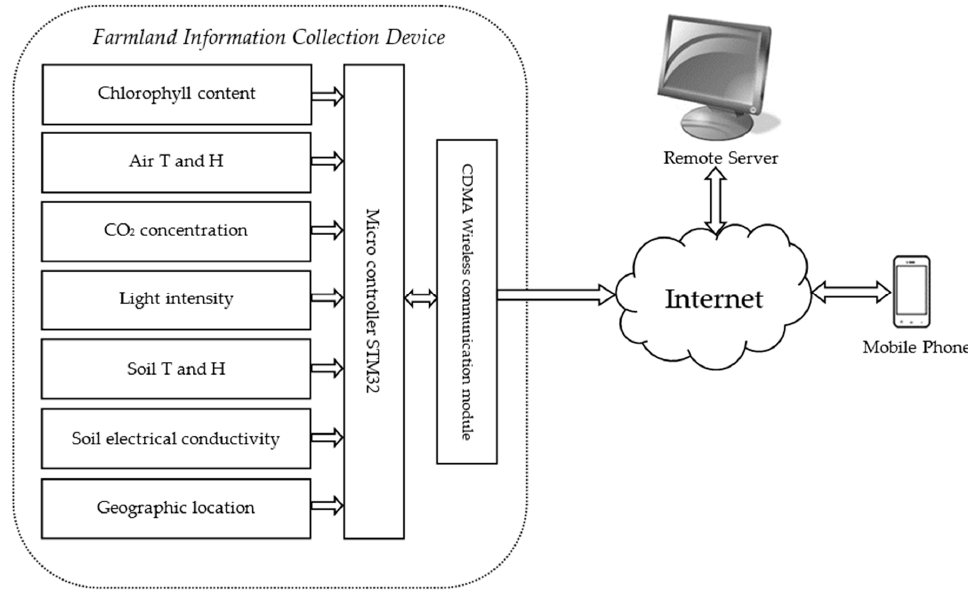
Figure 1. Scheme of the farmland information collection system.